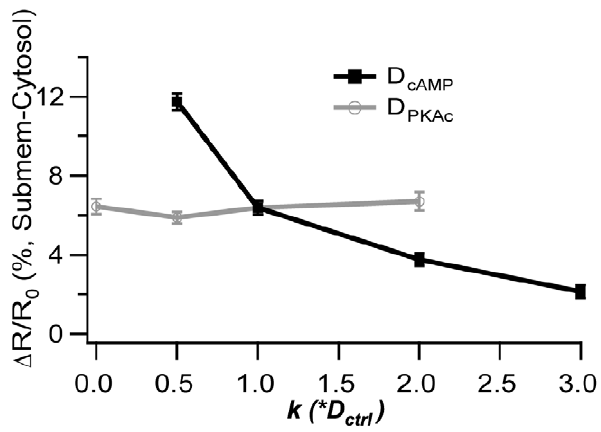
Figure 7. Amplitude of the microdomain is influenced by cAMP diffusion coefficient, but not by PKAc diffusion coefficient. Impeded diffusion of cAMP is not required for the microdomain, but influences the concentration difference between submembrane and cytosol. The faster the cAMP diffusion coefficient, the smaller the difference between submembrane and cytosol concentration (mea- sured as difference between FRET D F/F submembrane and FRET D F/F cystosol (solid black line, black squares). cAMP diffusion coefficient ranges from k=0.5 to k=3 times its control value of 295 m m 2 /s). Diffusion of the PKA catalytic subunit plays no significant role in generating cAMP microdomains (solid gray line, open squares). PKAc diffusion constant ranges from k=0 to k=2 times its control value of 59.54 m m 2 /s.